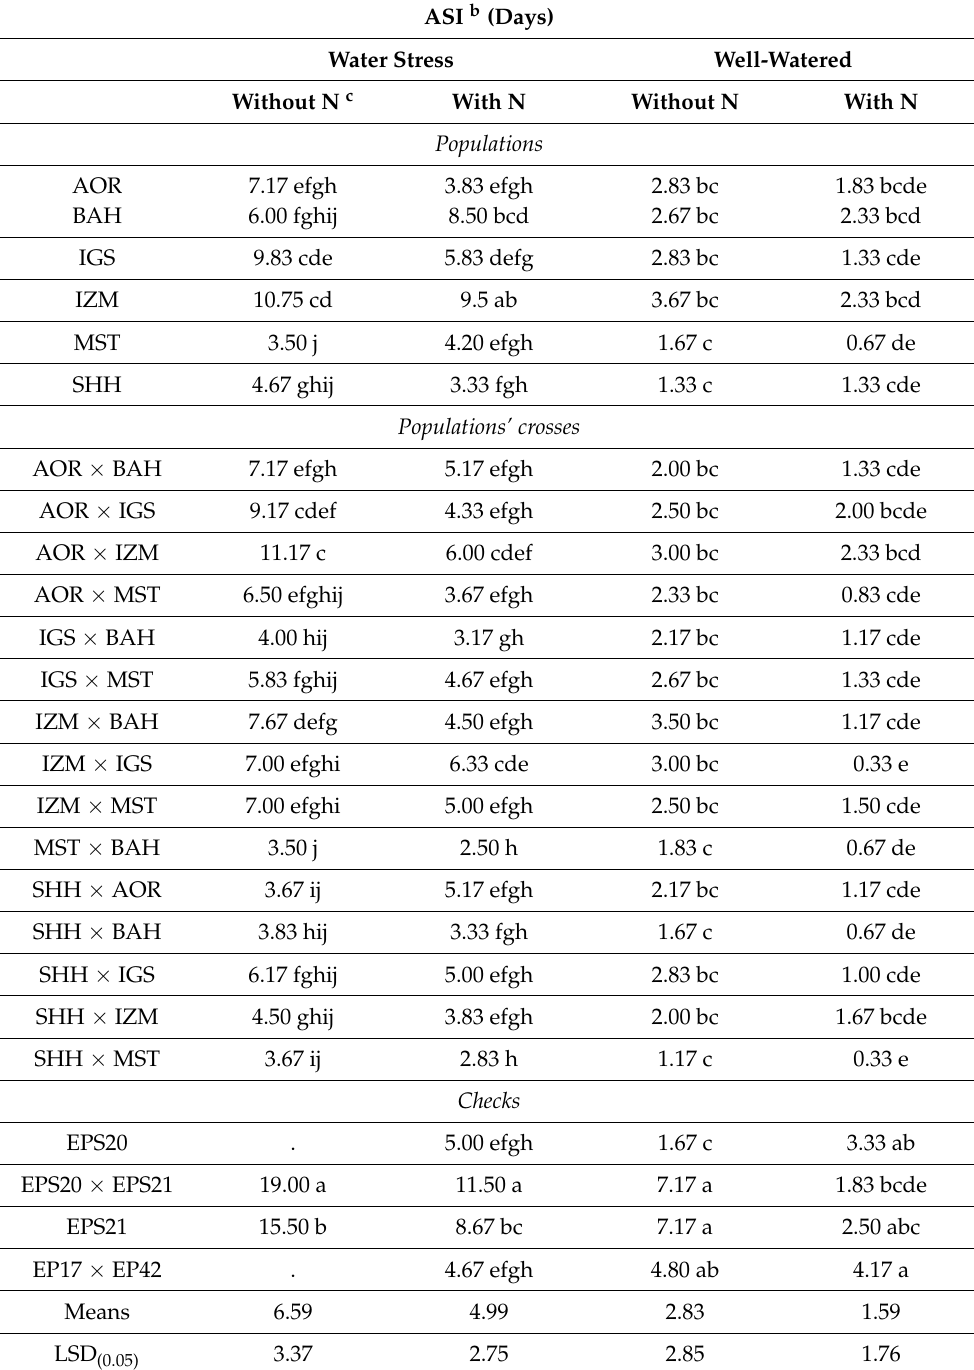
Table 1. Means a of anthesis–silking interval (ASI) and grain yield from a diallel systems with six Algerian maize populations evaluated along with four checks in two years in Algiers, under both managed drought and nitrogen